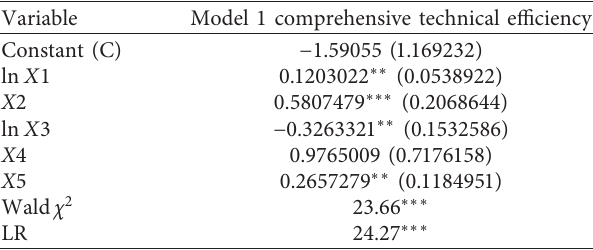
Table 6: Tobit regression